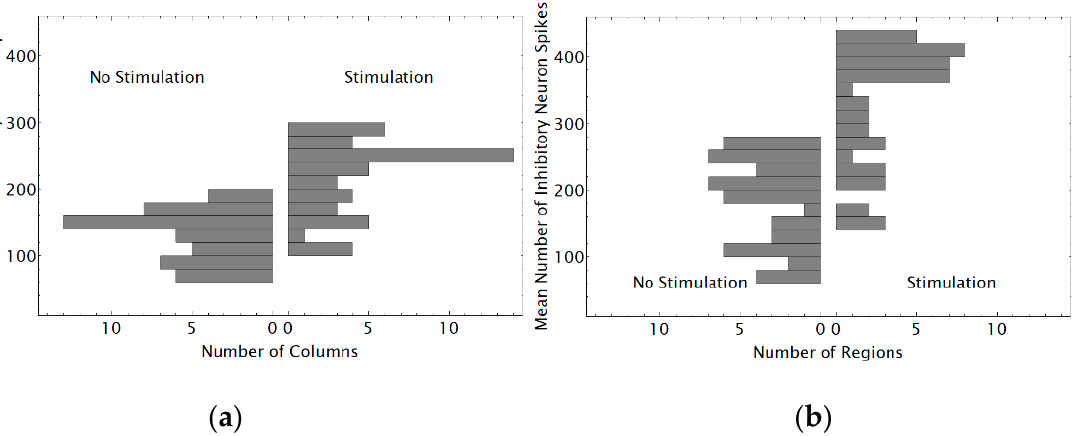
Figure 7. The distributions of numbers of spikes for network excitatory ( a ) and inhibitory ( b ) neurons in columns 1–49 averaged over 10 s simulations are shown for both no stimulation and stimulation conditions. The frequency of extrinsic excitatory action potentials was set to 70/s .